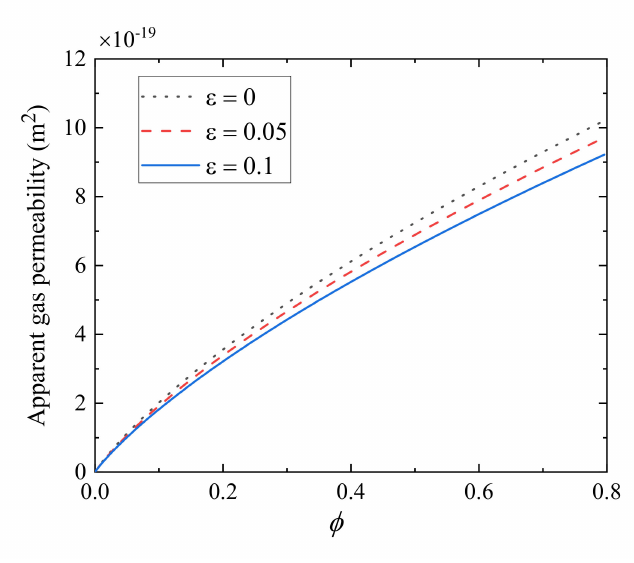
Figure 5. Effect of the porosity on the apparent permeability at different relative roughness.